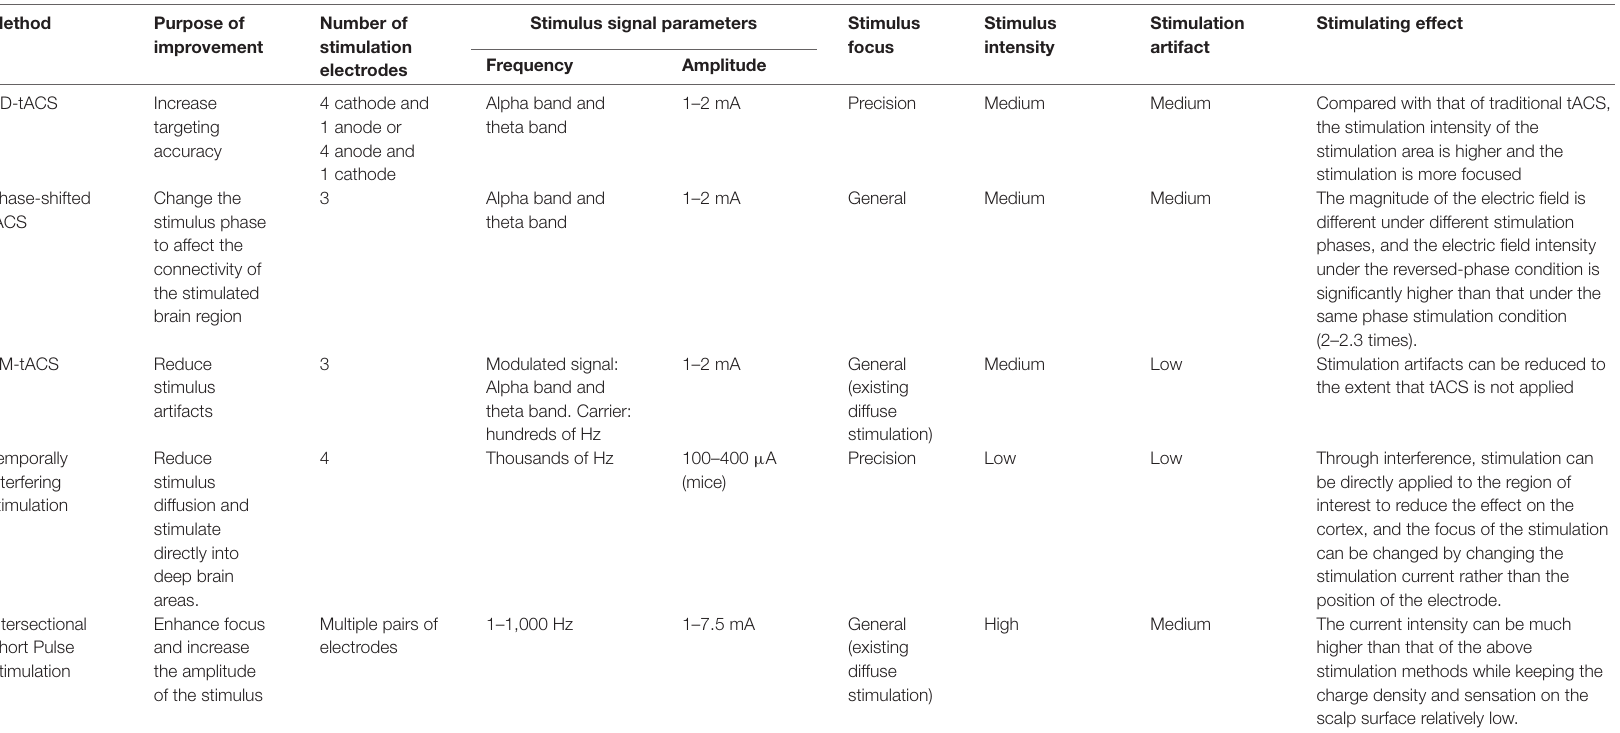
TABLE 3 | Comparison of different tACS improvement